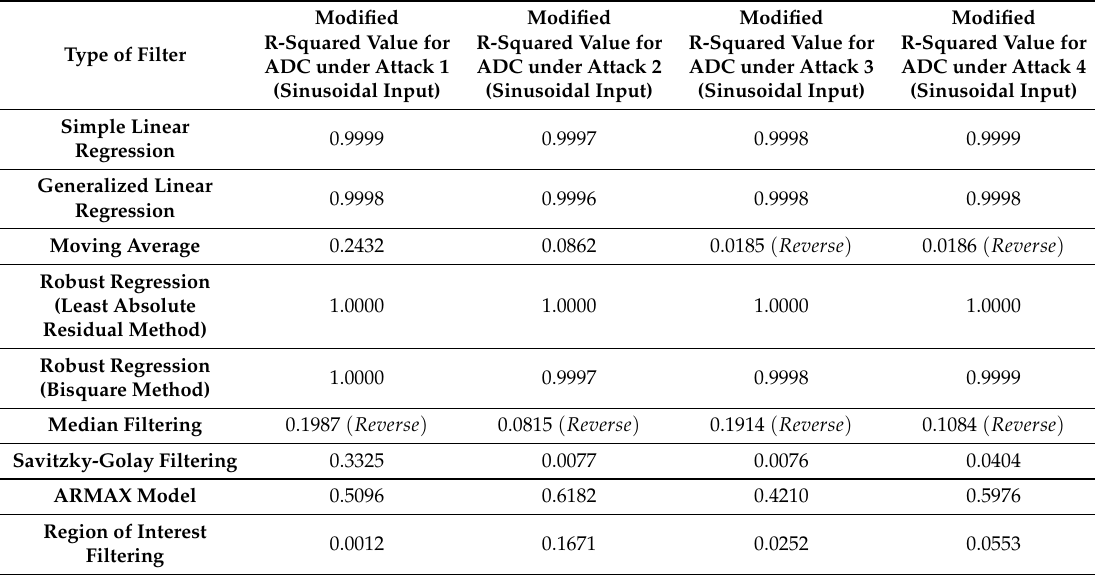
Table 4. Defense Analysis Under Process Variations (1): The performance analysis of filters based on their corresponding modified R-squared values when a sinusoidal signal is applied to the modulator and the threshold voltage of the transistors is 20% higher than its typical value.